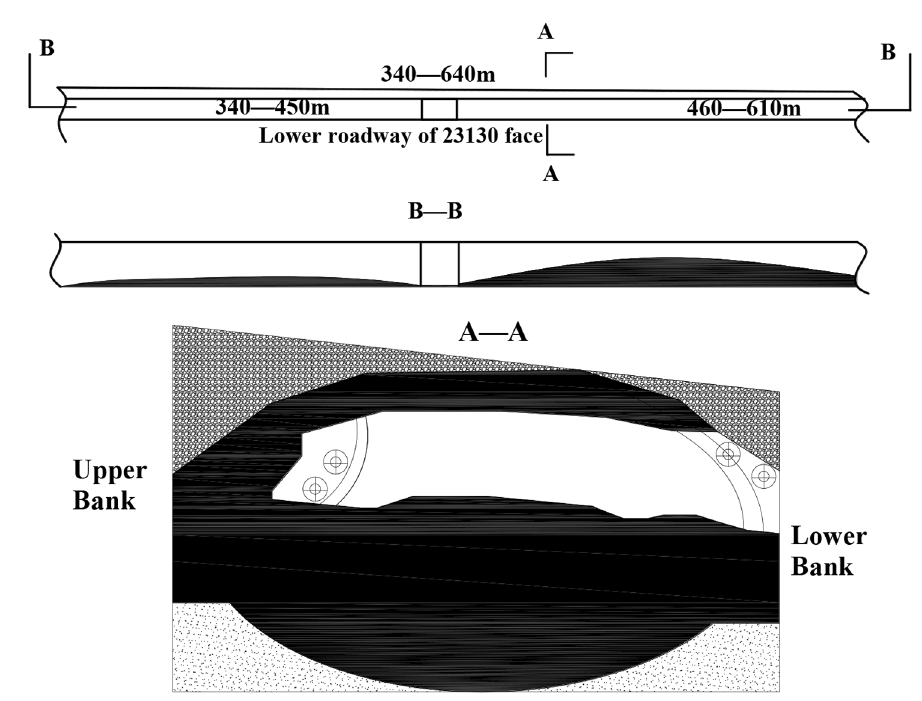
Fig. 4 Damage profile of the 23130 lower